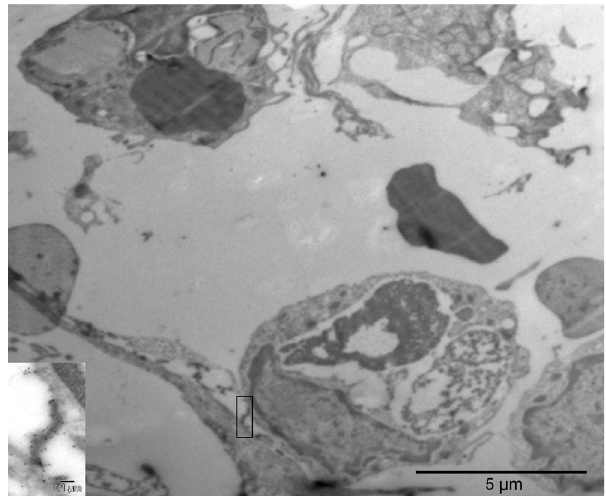
Figure 7. Relative location of megakaryocyte, erythroblast and ECs precursors in situ. Compare with Figure 6 [A,B & C]. The insert shows calmyrin-containing extracellular fibers connecting the adjacent cells.